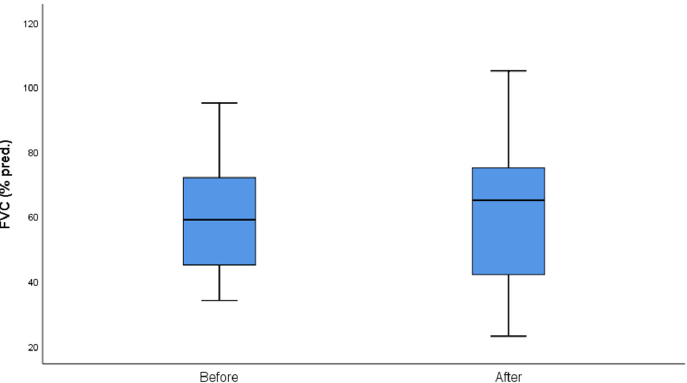
Figure 1. FVC (% pred) before and after nintedanib treatment.